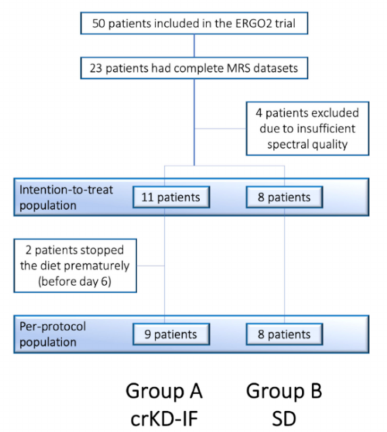
Figure 2. Consort flow diagram of the ERGO 2 MRSI